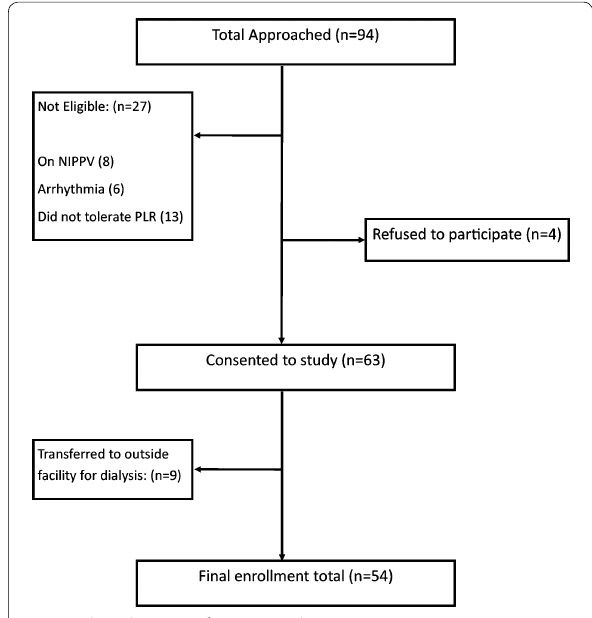
Fig. 1 Flow diagram of patient